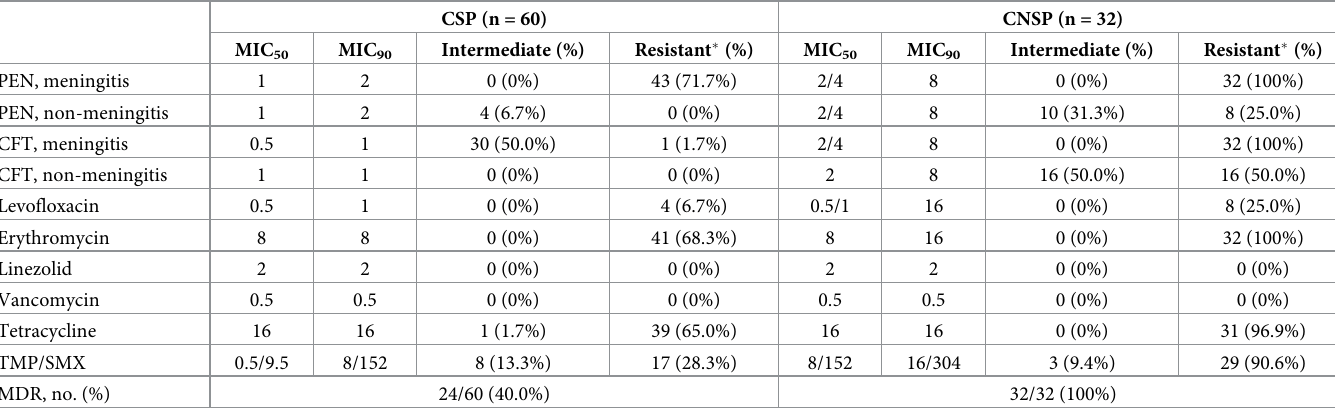
Table 2. Antibiotic susceptibility to diverse antimicrobial